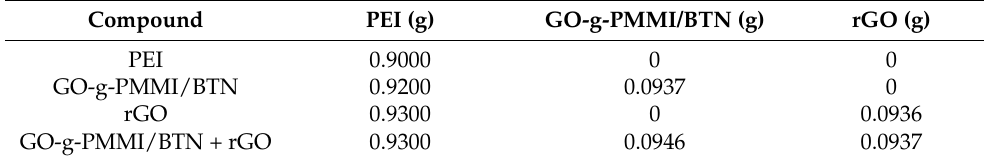
Table 1. Mass of PEI and fillers used for the preparation of the nanocomposites.